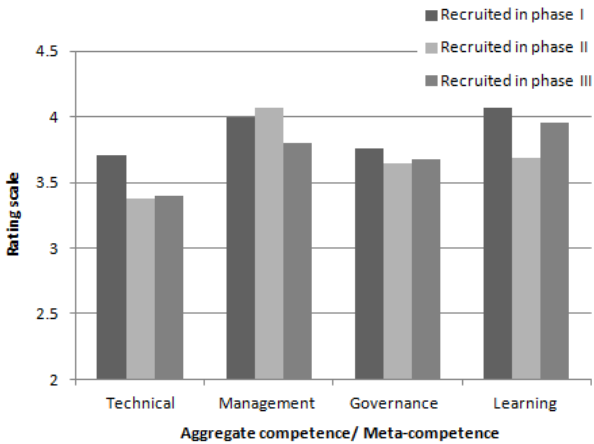
Fig. 2. Aggregate competences and meta-competence perceived to be required for daily tasks in the DGWR as rated by alumni from local post-graduate education and alumni from international post- graduate education; rating scale from 1 to 5, where 1=not at all, 3=to some extent, and 5=extensively.